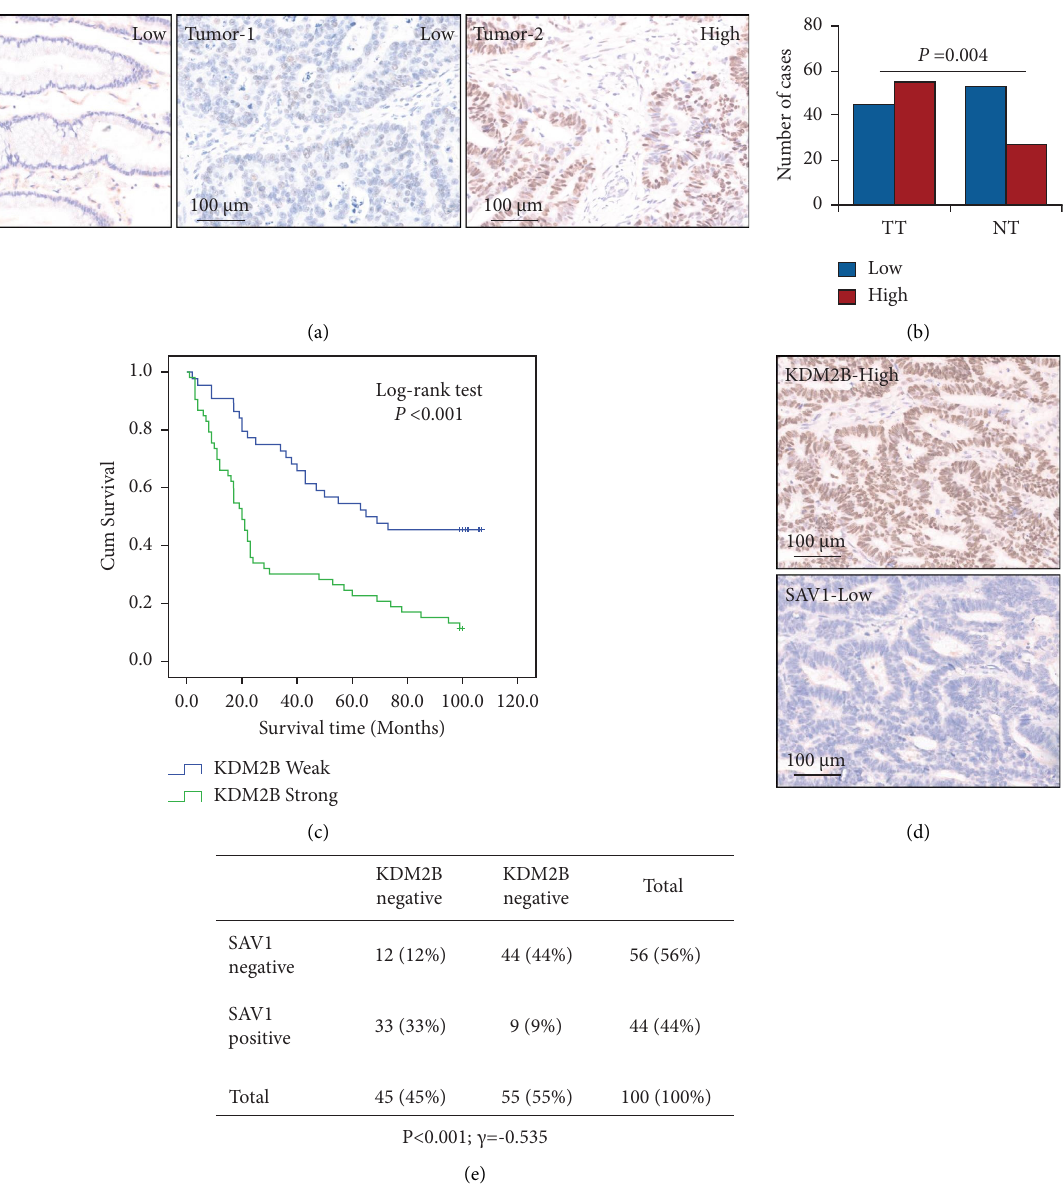
Figure 5: KDM2B expression is associated with GC progression and SAV1. TMA GC specimens were immunostained with a specifc anti- KDM2B antibody. (a) Representative images of KDM2B expression in GC specimens and adjacent normal gastric tissue specimens. Markedly low KDM2B expression was observed in adjacent normal tissue (left panel), low KDM2B expression was observed in tumor tissue (middle panel), and high KDM2B expression was observed in tumor tissue (right panel). (b) KDM2B expression was signifcantly higher in tumors (TT) than that in adjacent normal tissue (TN). (c) KDM2B expression was negatively associated with the OS of patients with GC. (d) Representative images of high KDM2B expression and low SAV1 expression in TMA sections. (e) KDM2B and SAV1 protein expression in TMA sections from the cohort; the negative correlation between KDM2B and SAV1 expression was determined using Pearson’s correlation coefcient analysis. N � 100. R �− 0.535. P < 0 . 001. KDM2B, lysine-specifc demethylase 2B; GC, gastric cancer; SAV1, Salvador homologue 1; OS, overall survival; TMA, tissue protein levels of KDM2B and SAV1 in serial GC tissue arrays